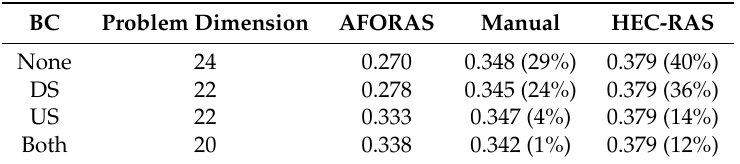
Table 2. Objective function values for the test cases with different boundary conditions. lower values represent better models. The numbers inside parentheses indicate what percent of the objective function value could be improved by running